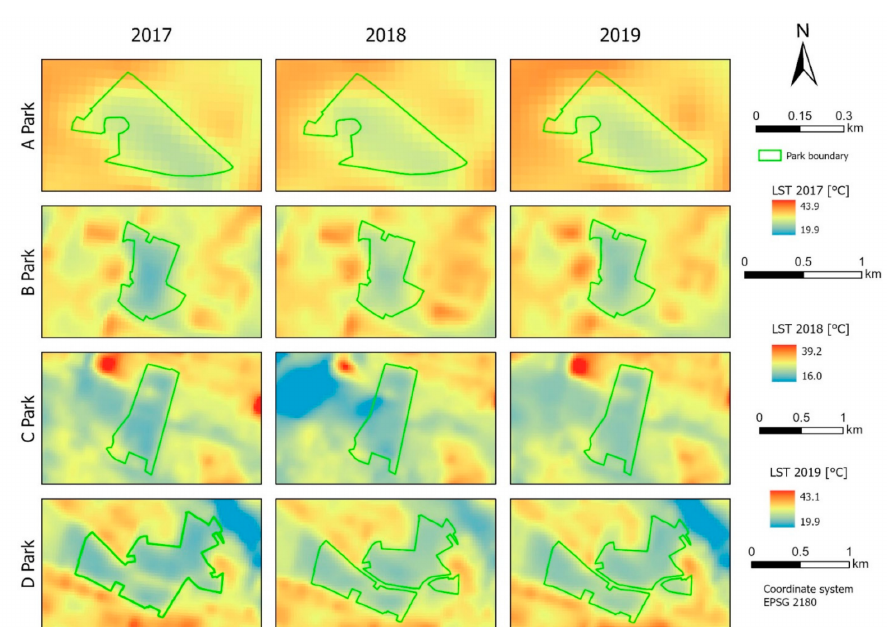
Figure A2. LST maps in the analysed